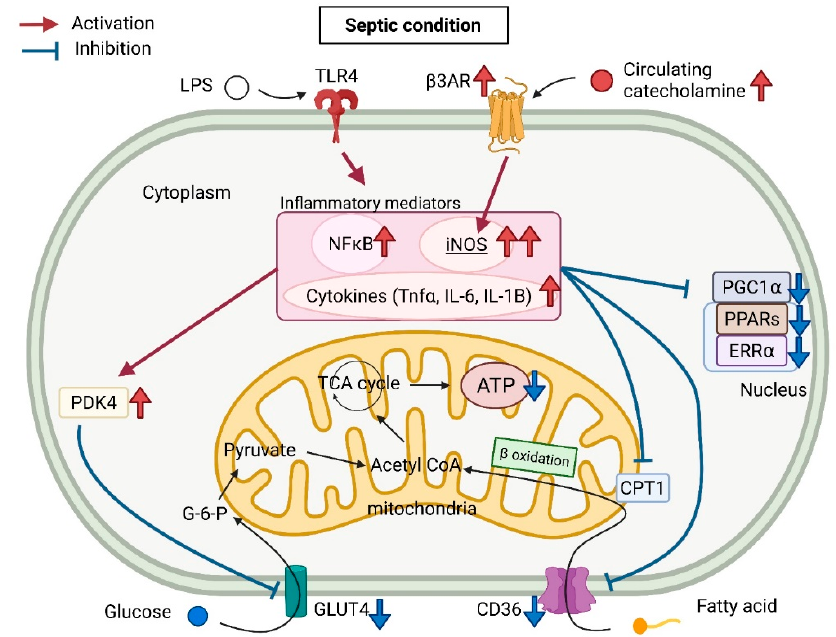
Figure. Schematic representation of myocardial metabolism in a septic